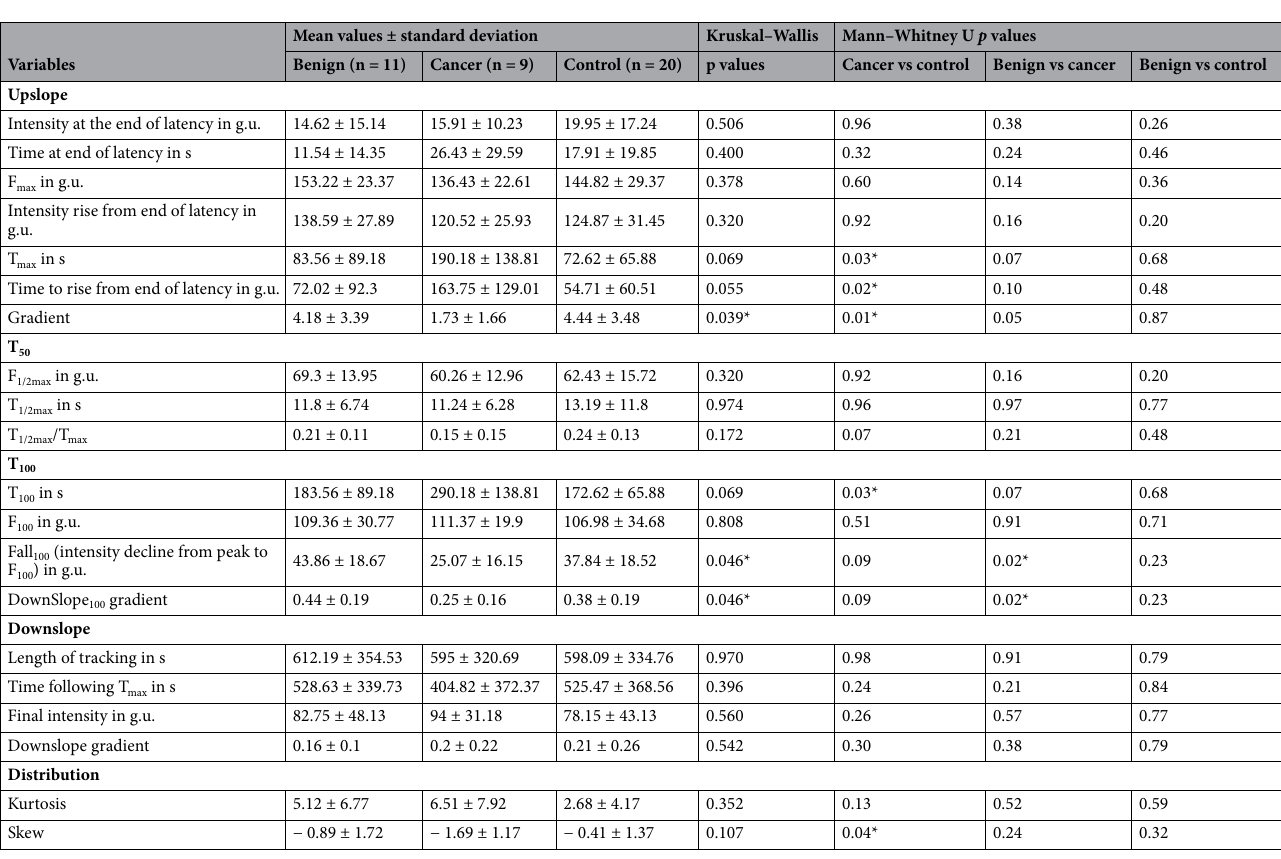
Table 3. Tabulated measures of graph parameters using the automated Fluorescence Tracker App (MATLAB®) of fluorescence intensity curves for videos of rectal lesions viewed in vivo, endoscopically under both